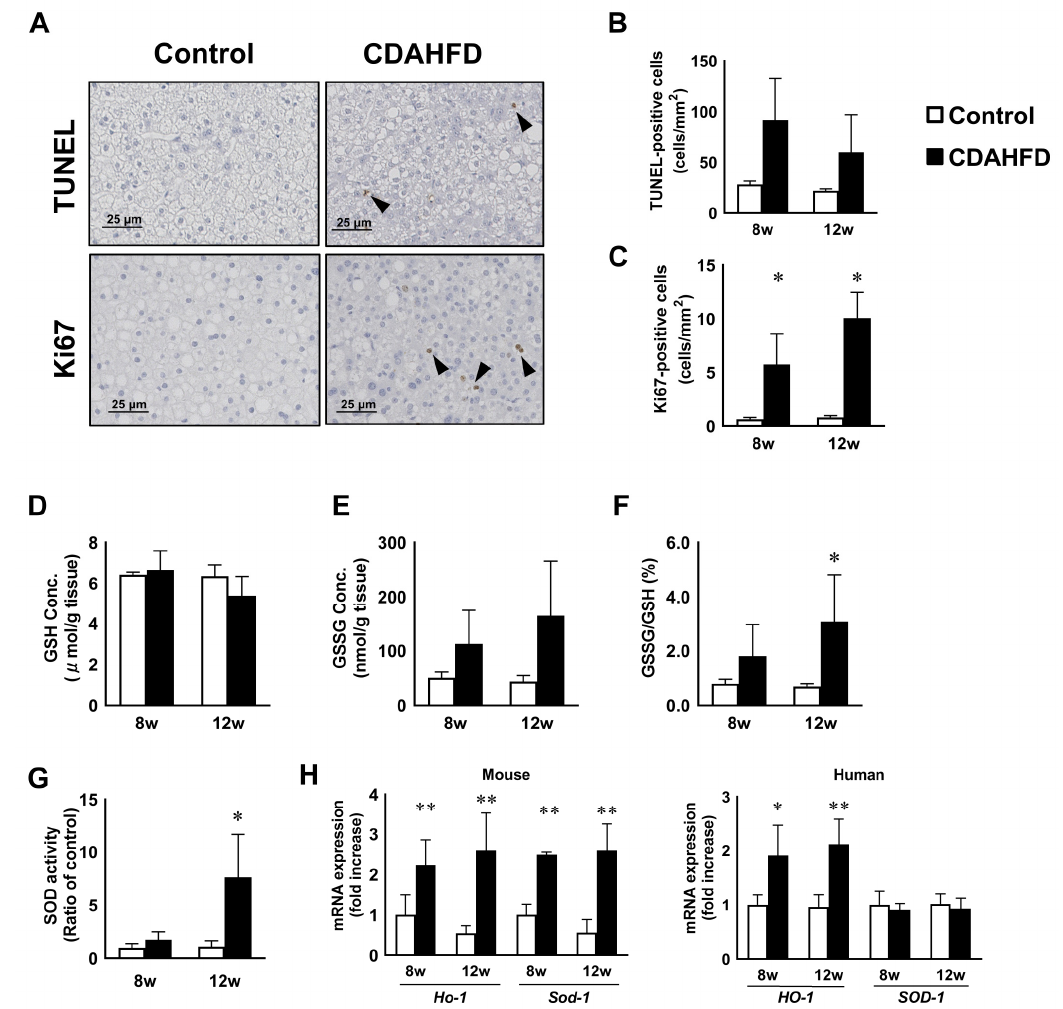
Figure 3. Apoptosis and proliferation of h-heps and oxidative stress in the liver of human chimeric mice after CDAHFD feeding. Representative images of TUNEL staining and immunostaining with a Ki67 antibody in the livers of the control and CDAHFD groups at 12 weeks ( A ). Positive cells are shown by arrows. Scale bar: 25 μ m. The number of TUNEL- ( B ) and Ki67- ( C ) positive cells in the livers of the control and CDAHFD groups at 8 and 12 weeks. Changes in the levels of GSH, GSSG, and the ratio of GSSG to GSH of control and CDAHFD-fed mice at week 8 or 12 ( D – F ). Changes in the SOD activities of control and CDAHFD-fed mice at week 8 or 12 ( G ). Changes in the levels of oxidative stress-related genes of the control and CDAHFD groups at 8 and 12 weeks ( H ). Results are expressed as the mean ratio of each value to the control group at 8 weeks. Opened and closed bars show the control and CDAHFD-fed mice, respectively. Results are represented as the mean ± standard deviation ( n = 4 per group). Statistical comparison among multiple groups was evaluated using ANOVA, followed by Tukey’s post hoc test. * Significant difference from the control group ( p < 0.05). ** Significant difference from the control group ( p < 0.01).